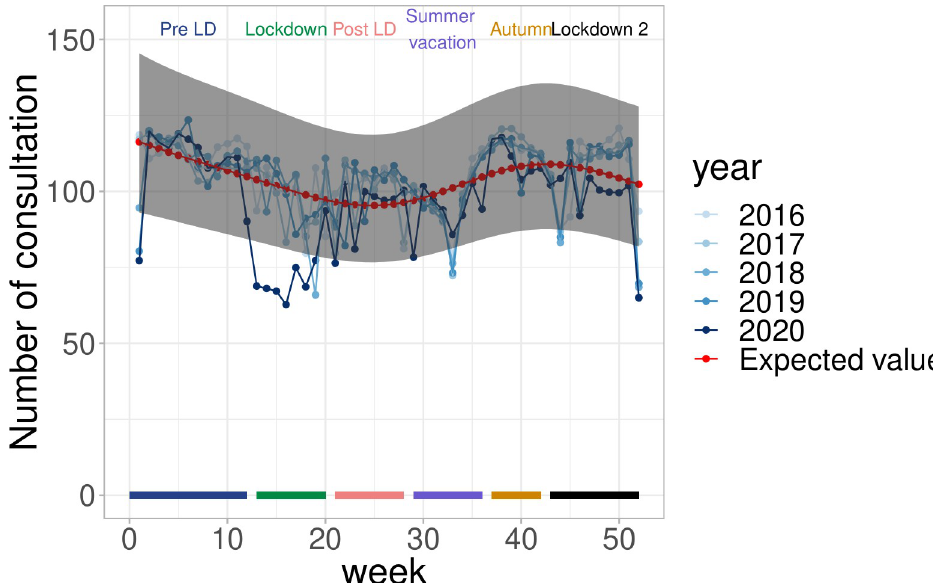
Fig 5. Number of general practitioner consultation in France during COVID-19 pandemic, IQVIA.